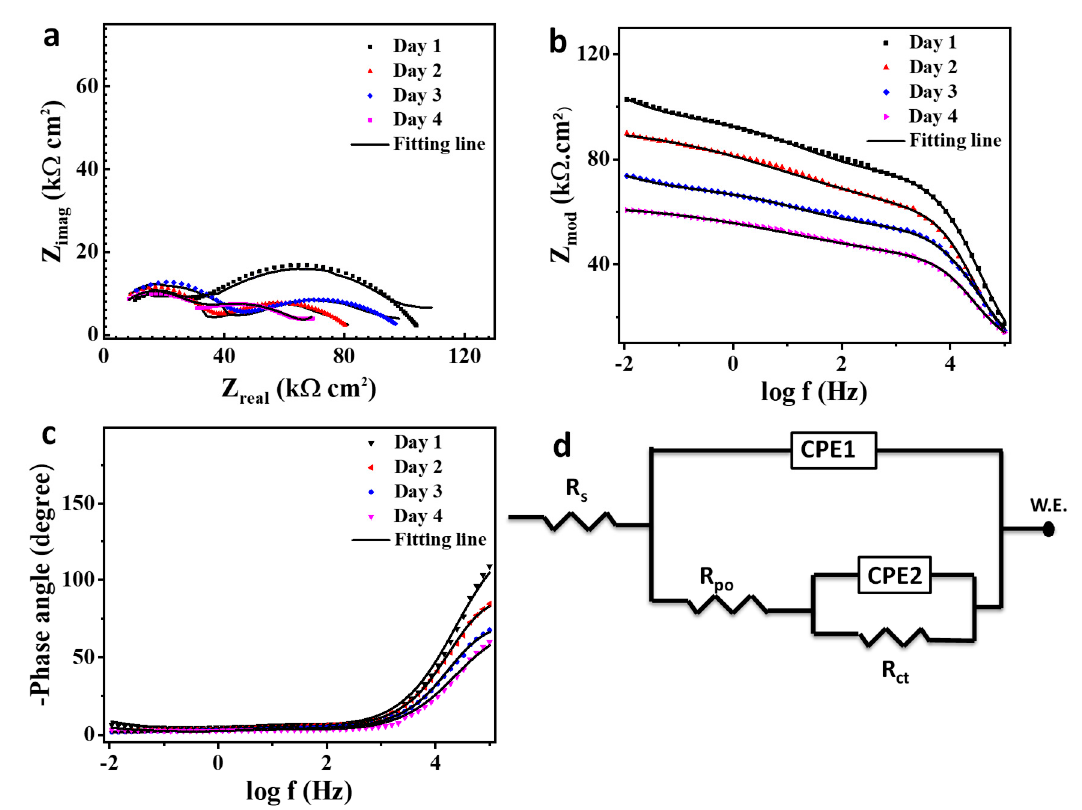
Figure 11. Electrochemical impedance curves for scratched pure coating immersed in 3.5 wt% NaCl for different exposure times: ( a ) Nyquist plot, ( b ) bode plot, ( c ) phase angle plot, and ( d ) the applicable equivalent circuit for the data fitting.